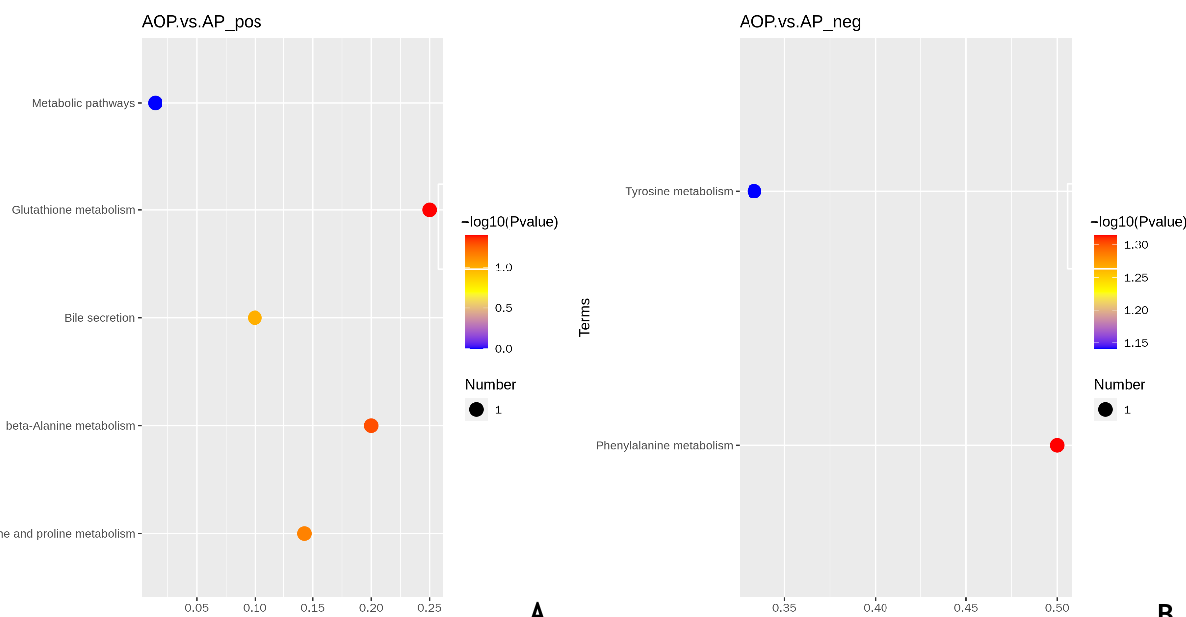
* dUMP represents uracil deoxyribonucleotide. ↑ represents upward adjustment; ↓ represents downward ad- justment. OP represents the group fed oat (n = 5). AOP represents the group fed a mixture of oat and alfalfa (n = 5).